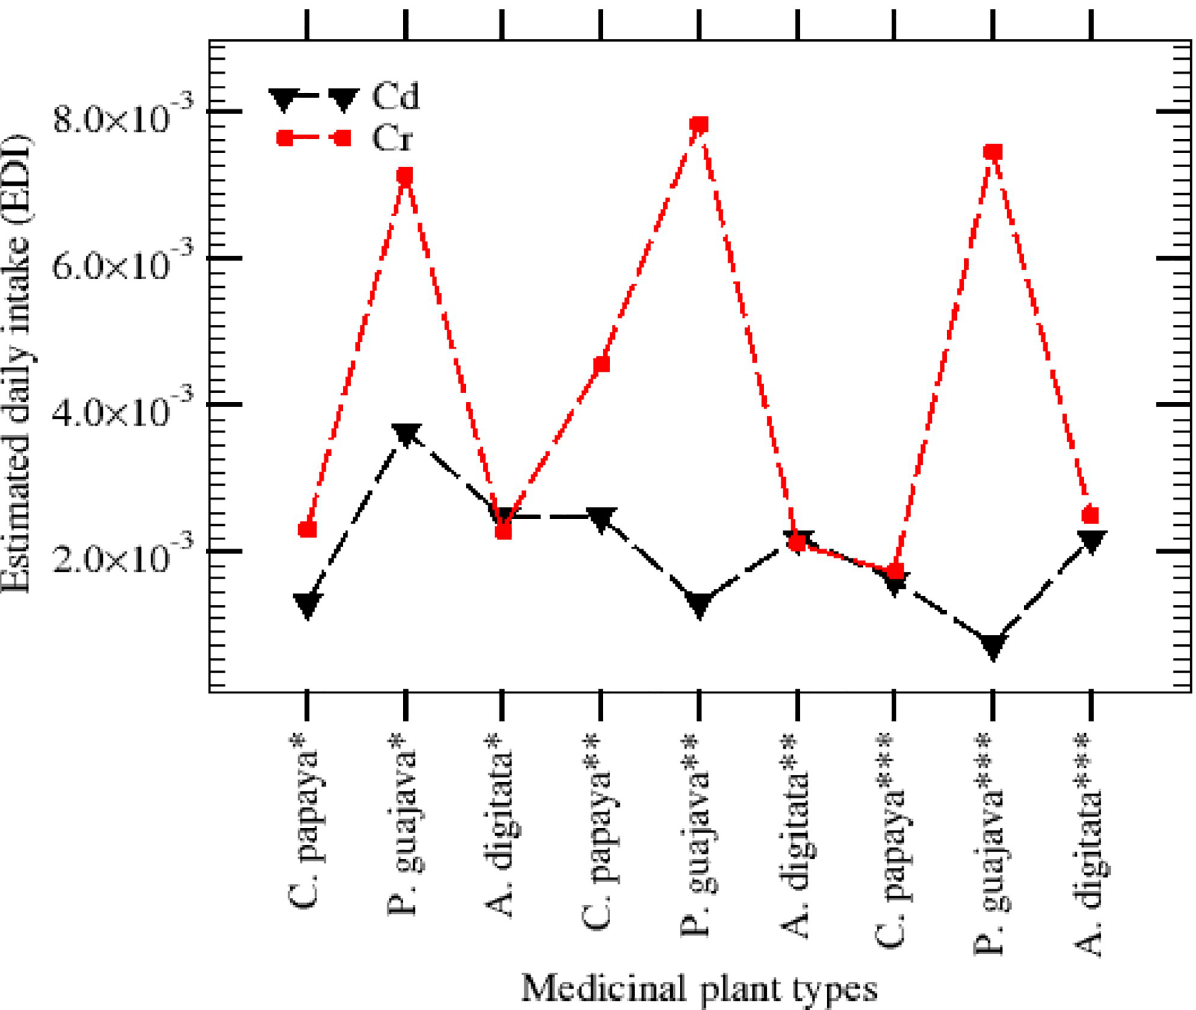
Fig 1. The estimated daily intake of Cr and Cd in the three herbs from Kanu, Jigawa, and Borno states.